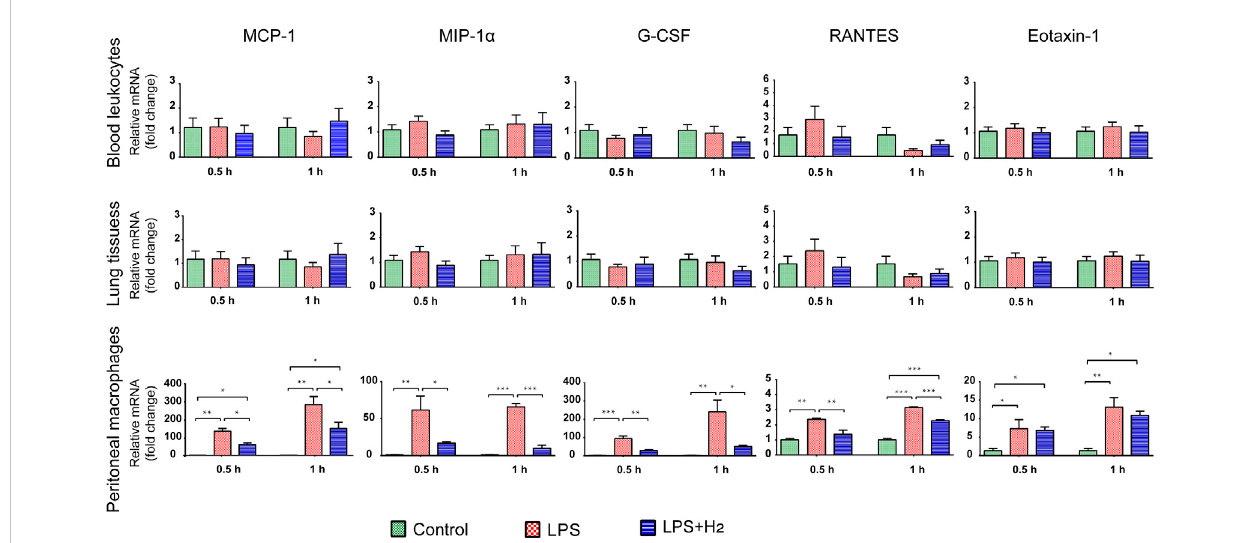
FIGURE 3 Effects of hydrogen on LPS-induced mRNA expression of fi ve chemokines in mouse lung tissues, leukocytes, and peritoneal macrophages, respectively,andtheonsettimepoints.ThemRNAlevelsofMCP-1,MIP-1 α ,G-CSF,RANTES,andEotaxin-1fromthemiceafterLPS(2 mg/kg)and/or42% hydrogen treatment were analyzed in triplicates at 0.5 h and 1 h time points. Data were expressed as mean ± SEM, * p < 0.05; ** p < 0.01; *** p < 0.001; n = 3.